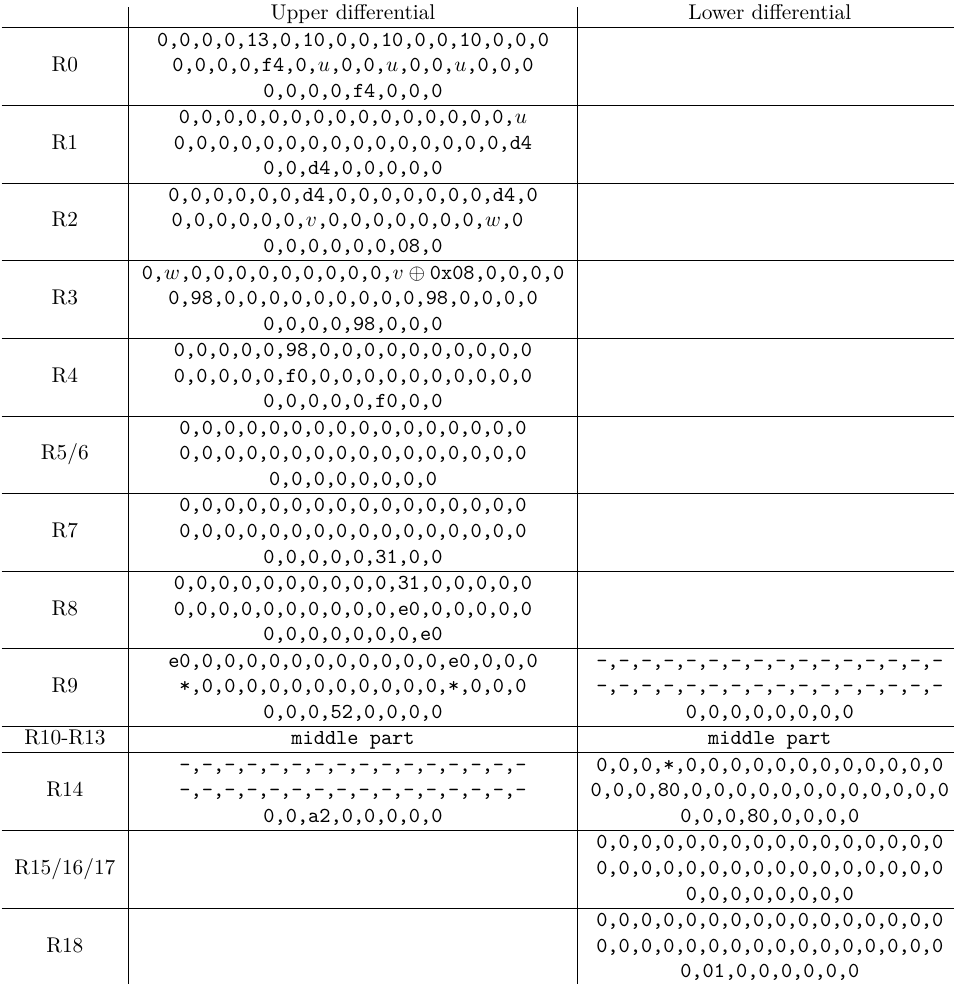
Table 18: The differentials of the 19-round distinguisher for Skinny-128-256 , where R9 to R14 denote r = 6-round middle part, u satisfies DDT[ 0x10 ][ u ] > 0 and DDT[ u ][ 0xd4 ] > 0, m v satisfies DDT[ 0xd4 ][ v ] > 0 and DDT[ v ⊕ 0x08 ][ 0x98 ] > 0, w satisfies DDT[ 0xd4 ][ w ] > 0 and DDT[ w ][ 0x98 ] >